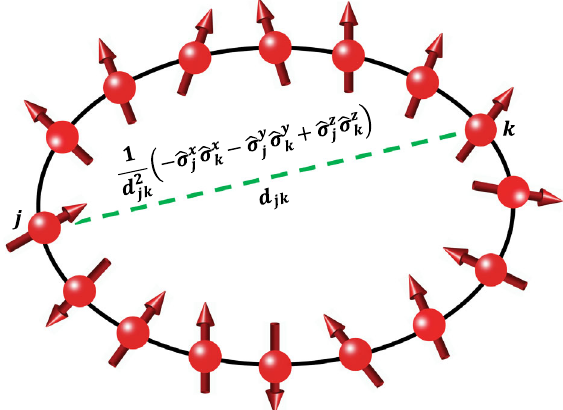
FIG. 6. The modified Haldane-Shastry model. The N spin- 1 particles form an equally spaced lattice on a ring. Each spin is interacting with all the other spins. The interaction between spin j and k is of Heisenberg XXZ type, and its strength is inversely proportional to the square of the chord distance d jk [see Eq. (8)]. The ground state of this model has power-law entanglement and can be calculated with a restricted Boltzmann machine through reinforcement learning.